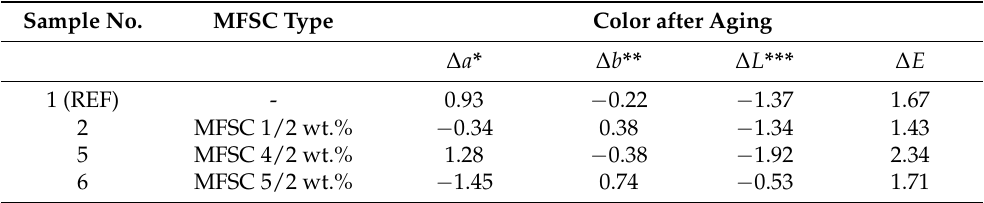
Table 7. ∆ L , ∆ a , ∆ b values and color ( ∆ E ∗ ) changes after aging. Sample No. MFSC Type Color after